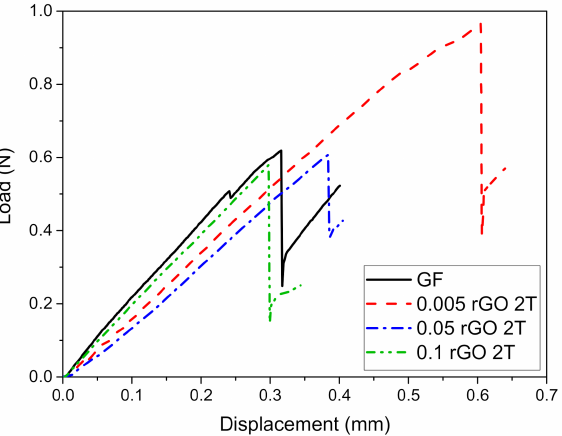
Figure 8. Comparison of load–displacement curves from microdebonding tests of uncoated GF and rGO coated GF, with electrification 2T.